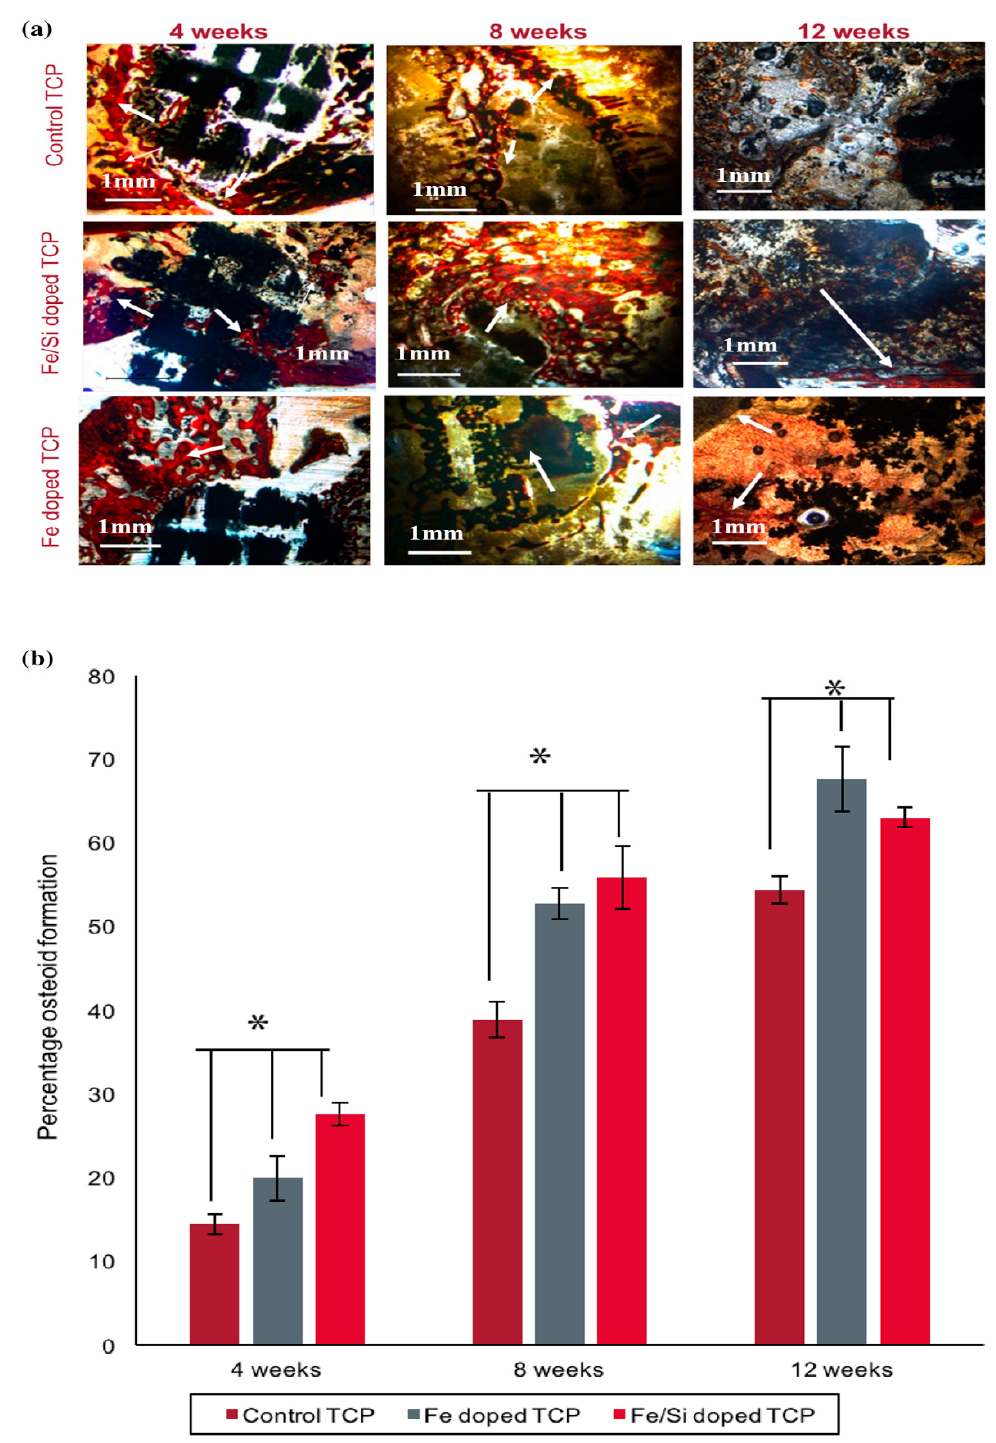
Figure 12. ( a ) Osteoid formation in pure and doped tricalcium phosphate (TCP) sca ff olds after Modified Masson-Goldner trichrome staining after 4, 8, and 12 weeks. Black: prosthesis, orange and red: osteoid, bluish green: mineralized bone. Reddish-orange colors indicated by arrows showing new bone formation. Fe doping showed more bone mineralization as compared to others. ( b ) Histomorphic analysis showed Fe-Si doped TCP boosted initial stage osteoid formation for the period of 8 weeks and Fe doped TCP shows better mineralization of bone for 12 weeks of implantation